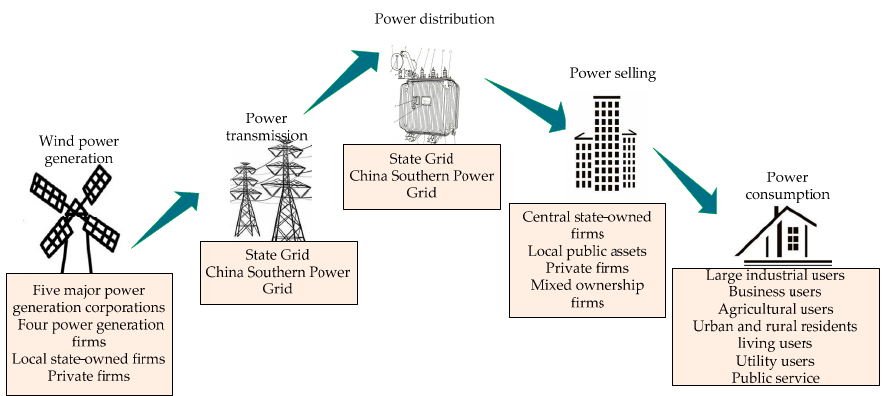
Figure 14. Firm strategy, structure and rivalry of wind power industry.